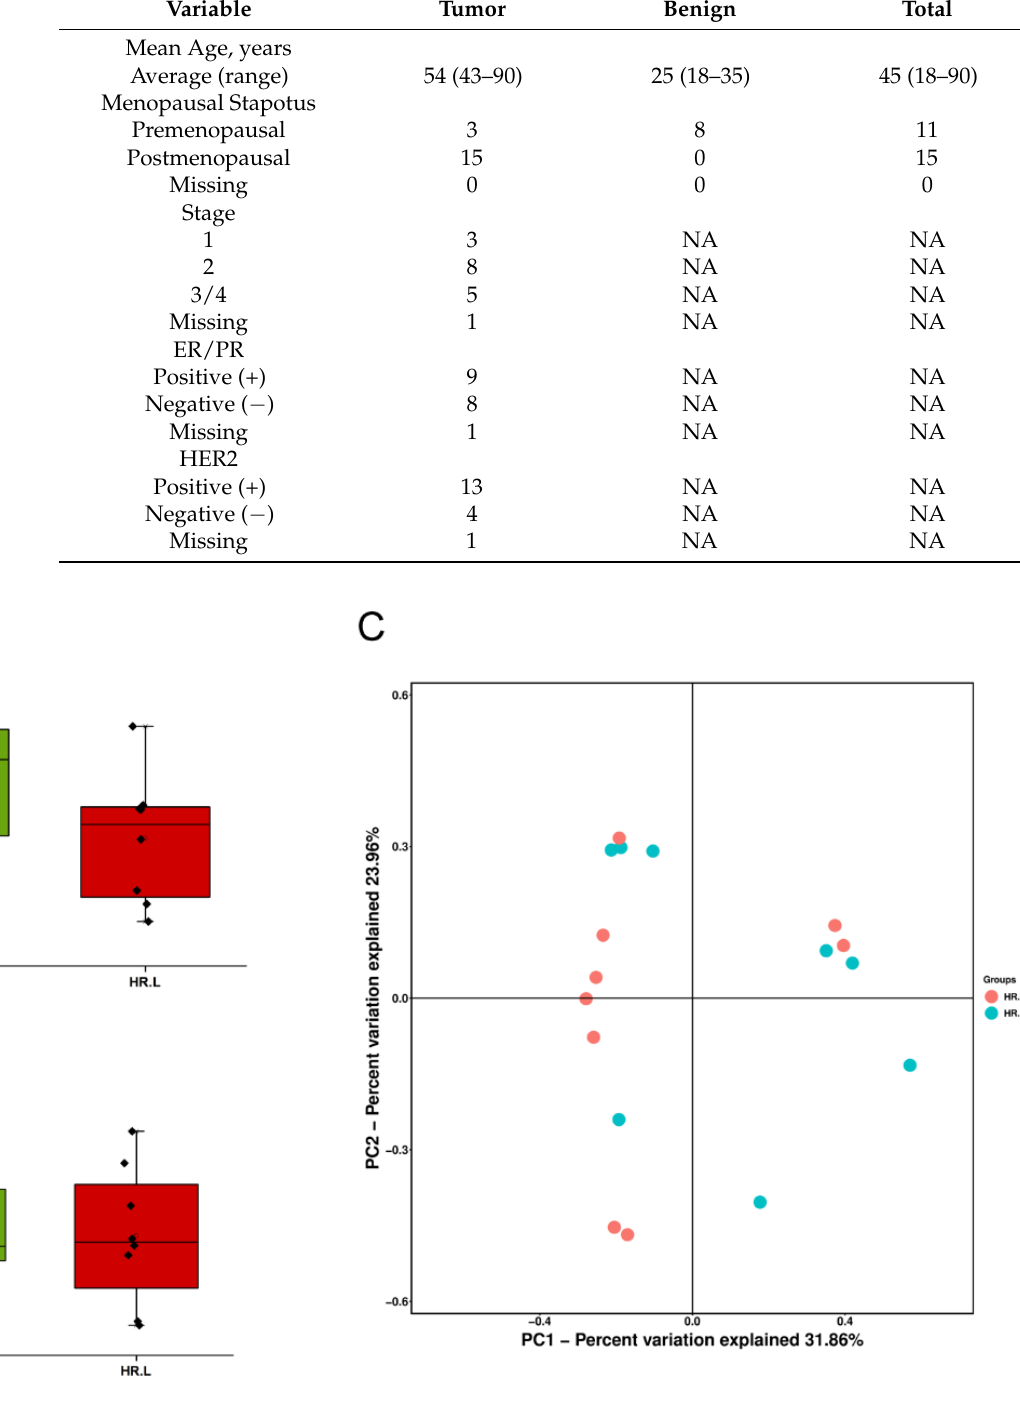
Figure 4. ( A ) Boxplot comparing Shannon index and ( B ) Chao1 between hormone-receptor-positive tumors and hormone-receptor-negative tumors (Shannon index, p = 0.121; Chao1, p = 0.805, Stu- dent’s t test). ( C ) PCoA plots show the clustering pattern of the two groups based on Bray–Curtis distance ( p = 0.687, Adonis). HR.H, hormone-receptor-positive tumors; HR.L, hormone-receptor- negative tumors.